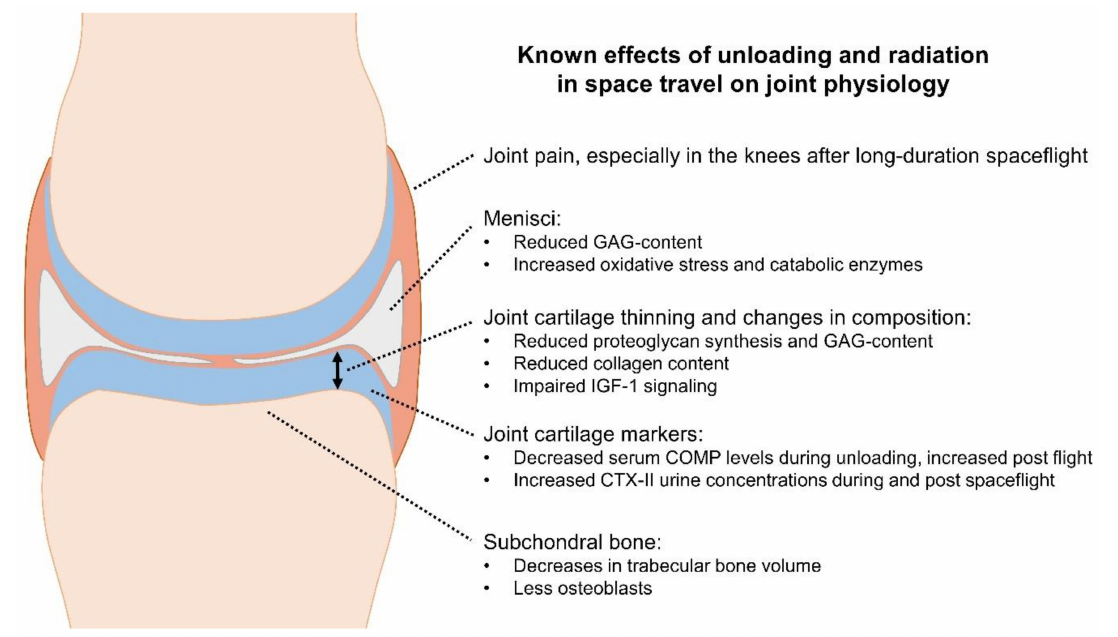
Figure 2. Illustration of the main known effects of unloading and radiation on joint